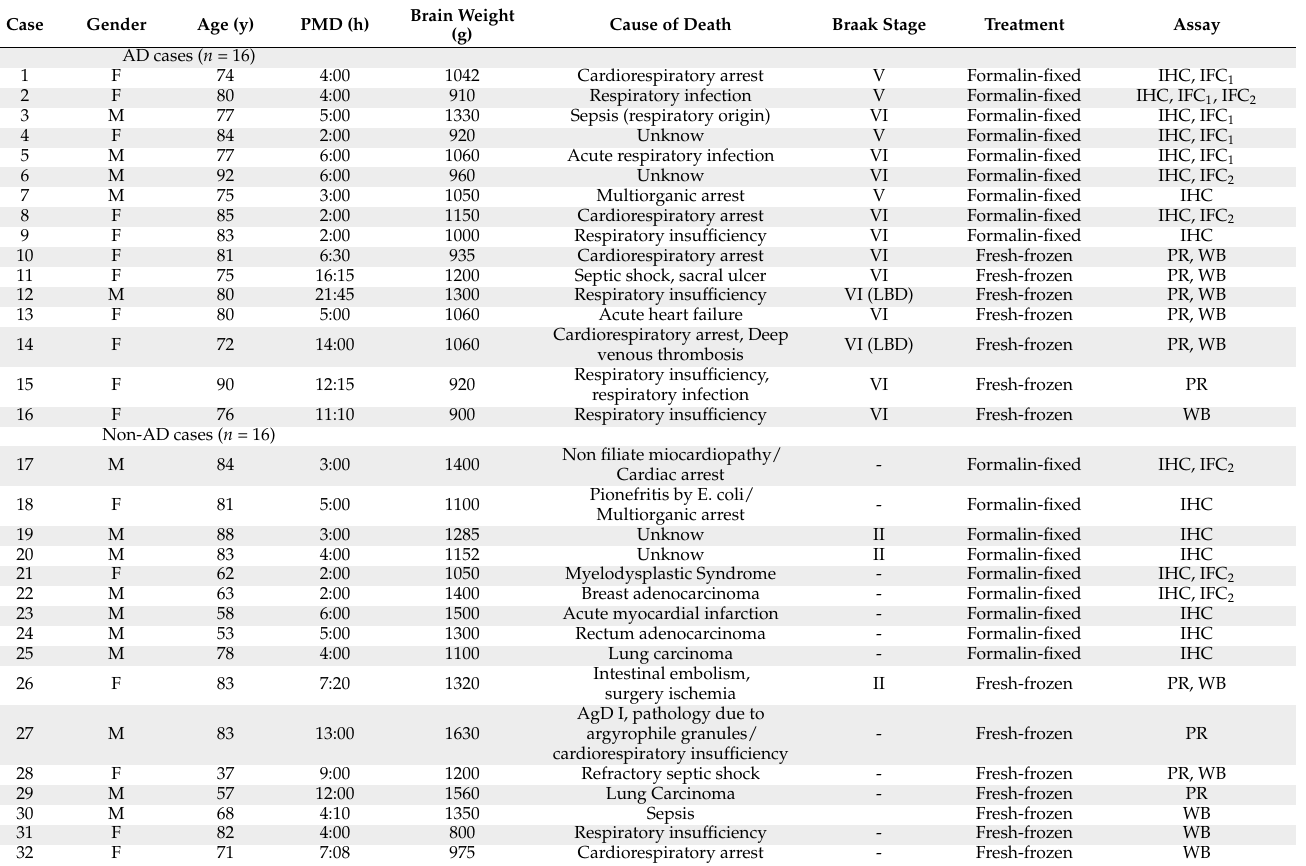
Table 3. Human samples. Detailed information about the samples employed in the